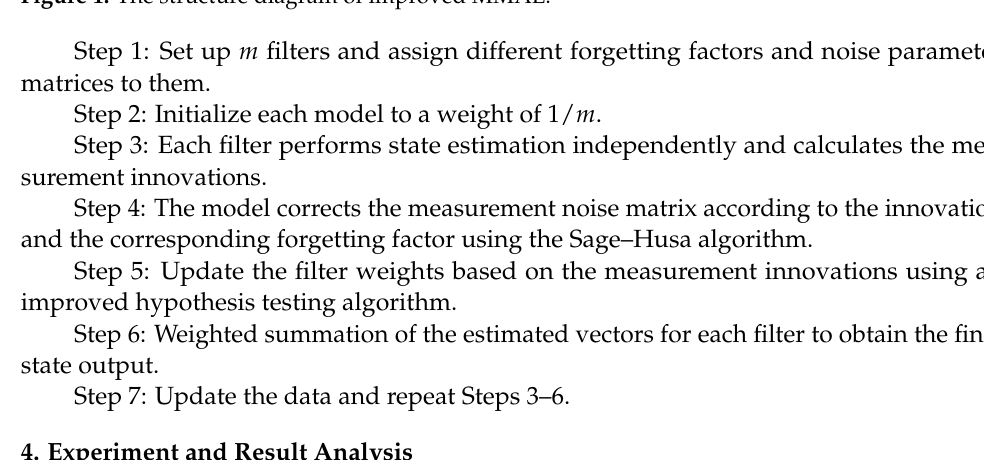
Figure 2. The structure of INS/GPS integrated navigation.